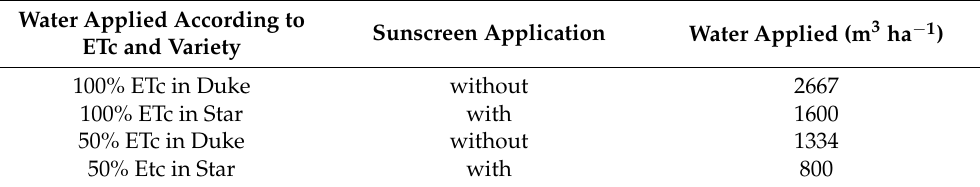
Table 2. Irrigation time and quantity of water applied in blueberry orchards under the growing season study for the 2014 season. Water Applied According to Sunscreen Application Water Applied (m 3 ha − 1 ) ETc and Variety 100% ETc in Duke without 2667 100% ETc in Star with 1600 50% ETc in Duke without 1334 50% Etc in Star with